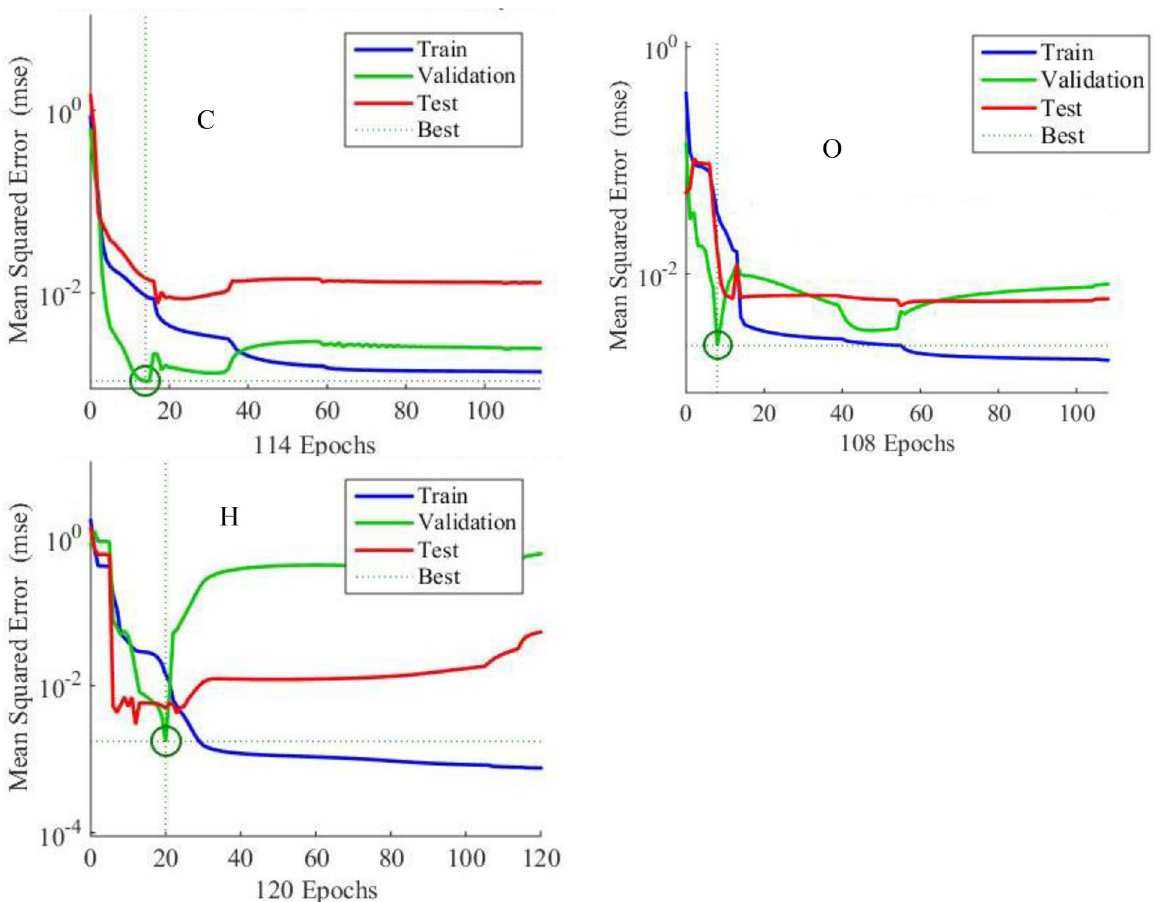
Fig. 2 Performances of the proposed ANN models for C, H, and O